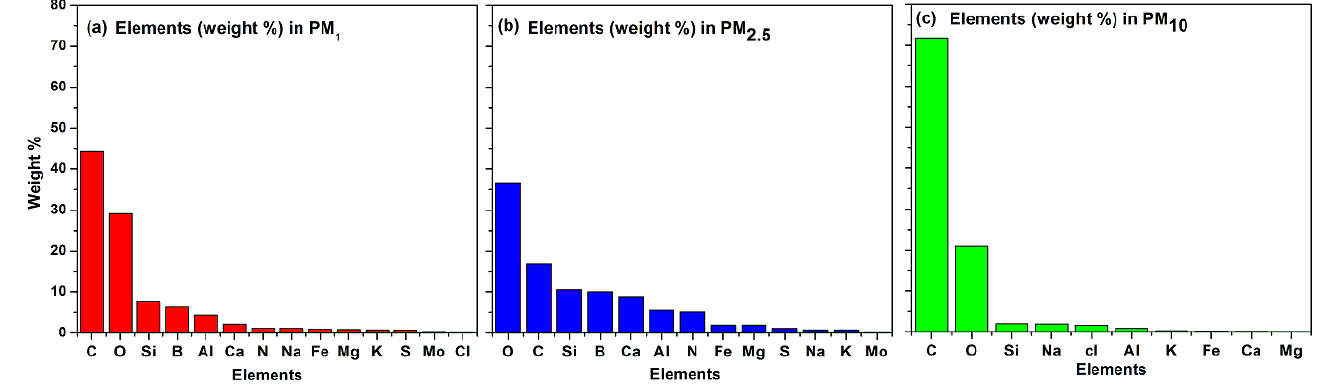
Figure 8. Summary of weight-wise percentage of 14 elements in PM 1 , PM 2.5 and PM 10 .